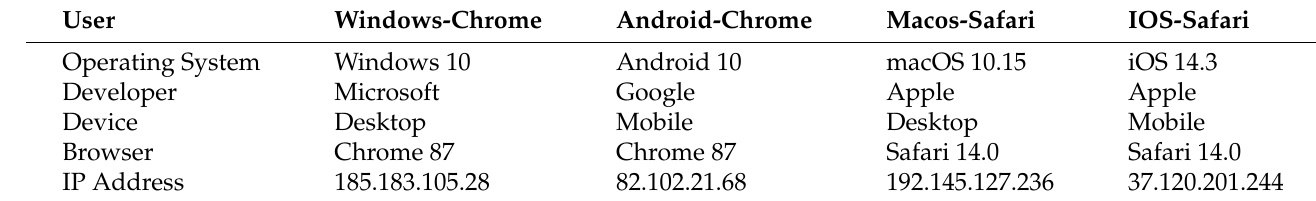
Table 2. Considered user